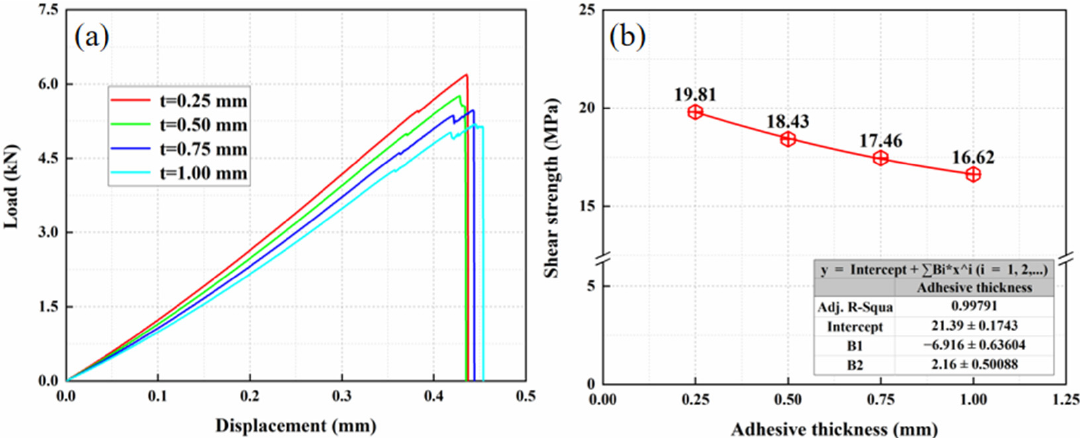
Figure 9. The result of different adhesive layer thickness: ( a ) load displacement curves and ( b ) shear strength.